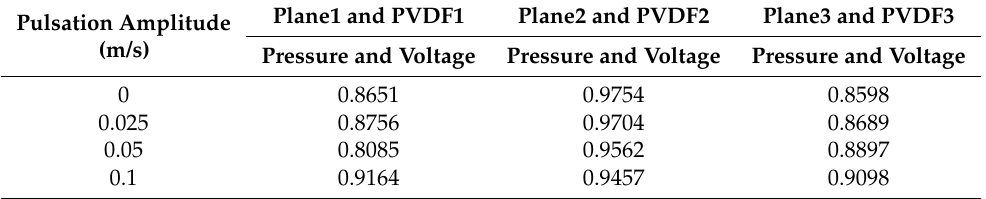
Table 6. Correlation coefficient.